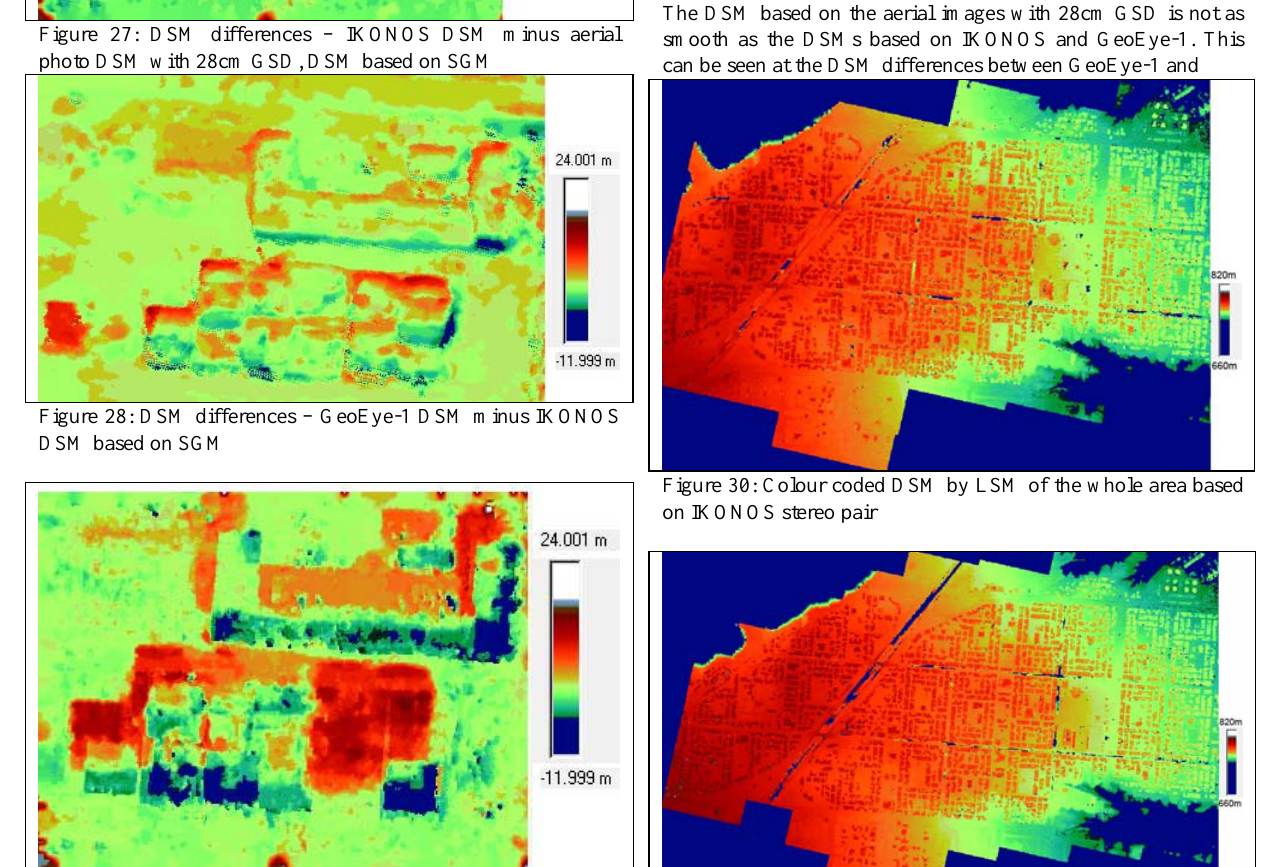
Figure 29: DSM differences – GeoEye-1 DSM – aerial image 28cm GSD DSM based on SGM